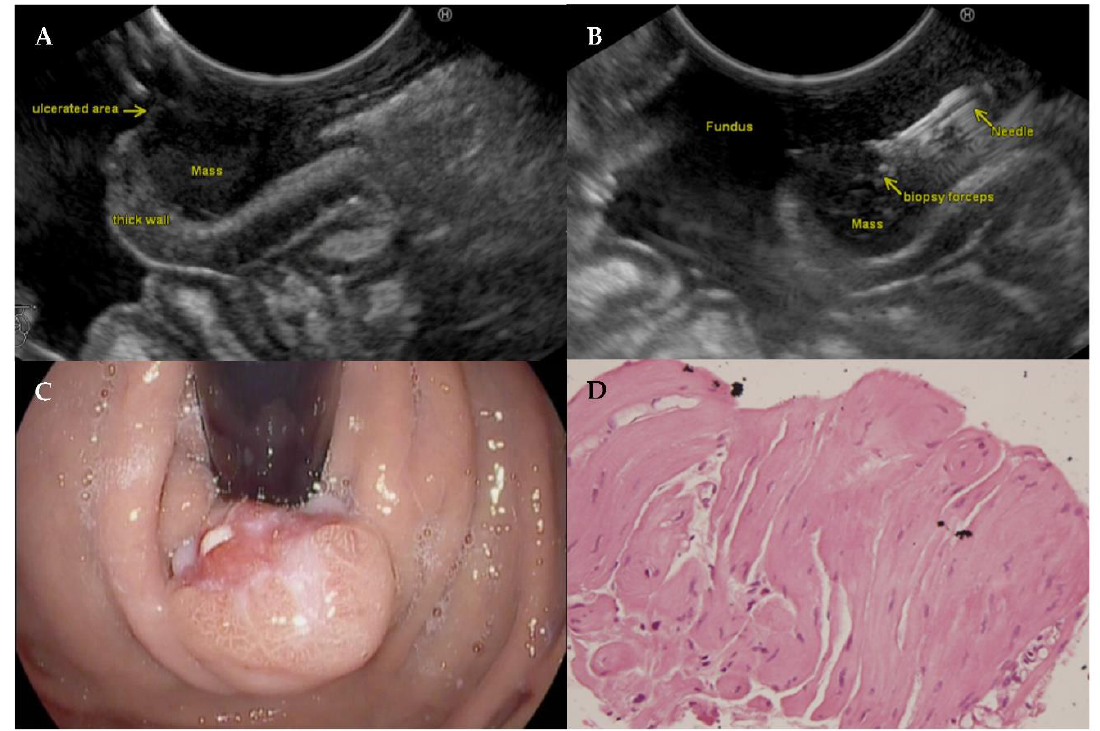
Figure 2. EUS image of subepithelial leiomyoma at gastroesophageal junction ( A ). EUS image of the leiomyoma with the opened puncture biopsy forceps needle inside ( B ). Gastroduodenal endoscopy of the subepithelial leiomyoma at the gastroesophageal junction ( C ). Hematoxylin and eosin staining of the histologic tissue fragment of the biopsy, magnification 400× ( D ).